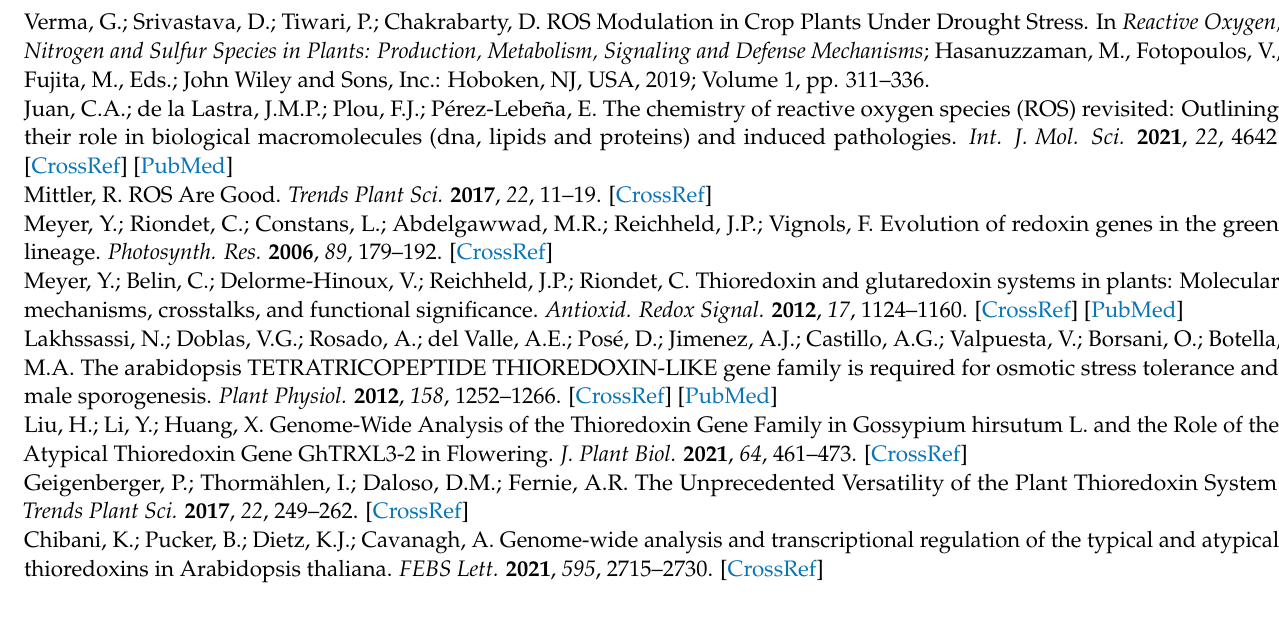
Figure S2: Thioredoxin gene family of Glycine max; Figure S3: Glutaredoxin gene Family of Glycine max; Figure S4: Prediction of cis-acting elements in the promoter sequences of Glycine max thioredox- ins (GmTrx); Figure S5: Prediction of cis-acting elements in the promoter sequences of Glycine max glutaredoxins (GmGrx); Table S1: General characteristics of thioredoxin homologs in Glycine max; Table S2: General characteristics of glutaredoxins in Glycine max; Table S3: General characteristics of the MEME motifs identified for GmTrx and GmGrx